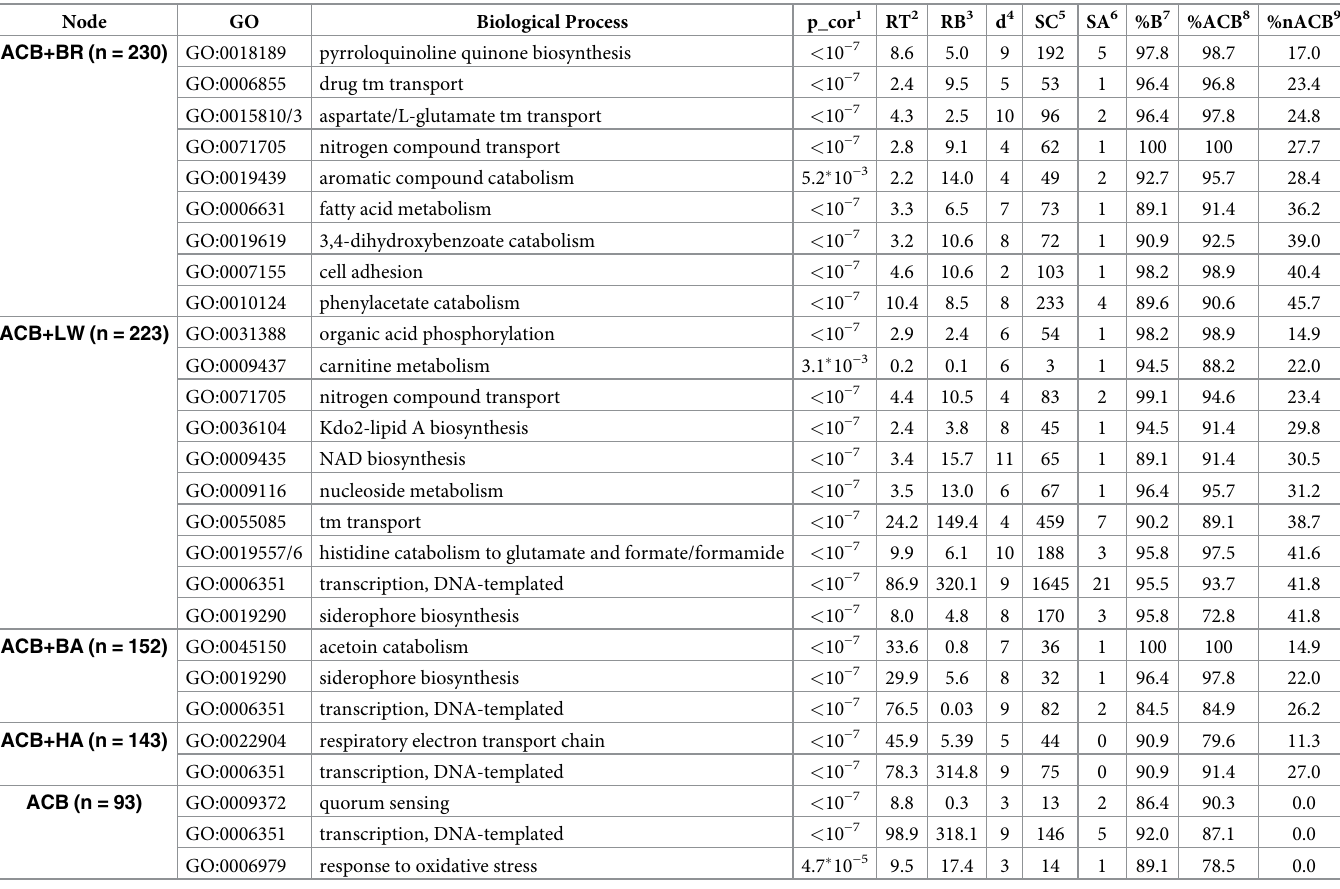
Table 1. Selection of overrepresented GO terms in the assigned gene sets of the inner nodes (The full list of enriched terms is provided in S5 Table, Table 1). Node GO Biological